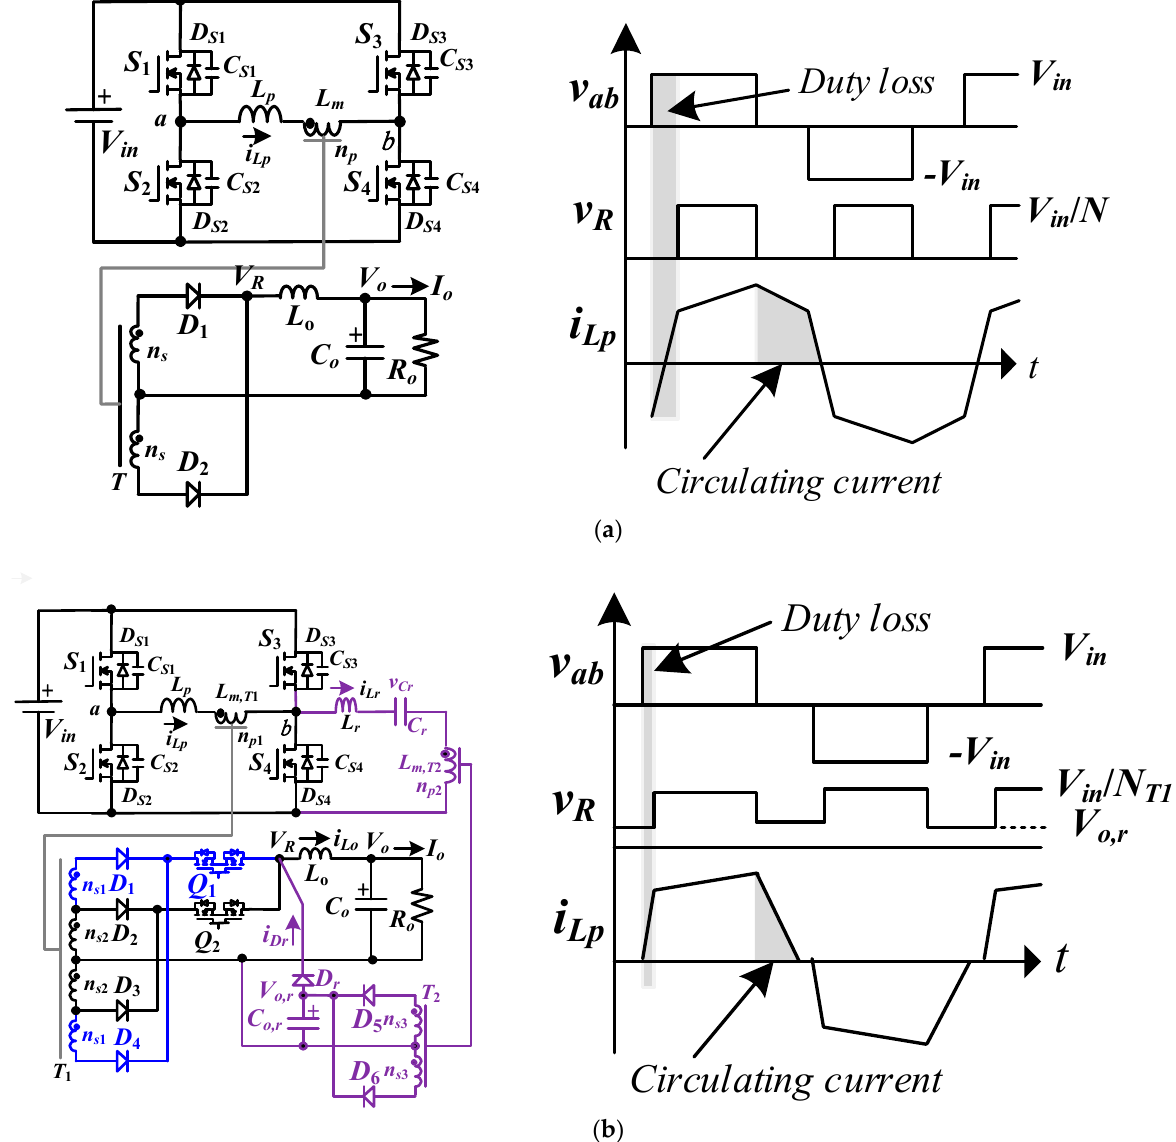
Figure 1. Circuit diagram ( a ) conventional phase-shift pulse-width modulation (PSPWM) converter and its pulse-width modulation (PWM) signals ( b ) presented circuit structure.